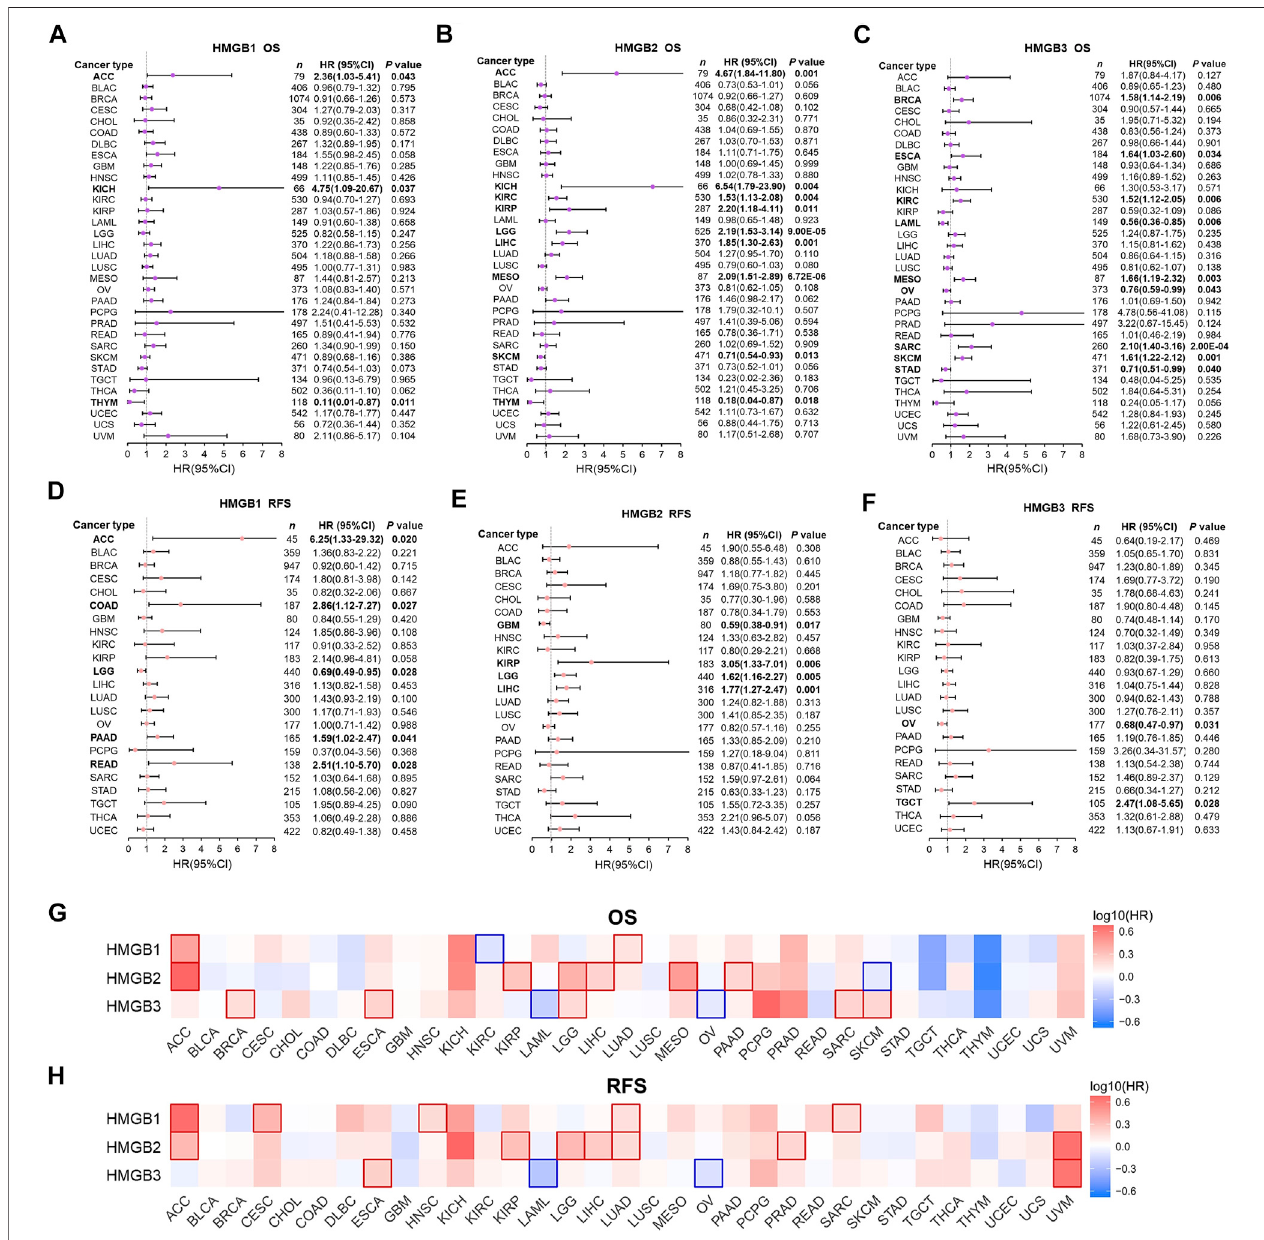
FIGURE 2 | Prognostic signi fi cance of High Mobility Group Box (HMGBs) in cancers. Associations between HMGB expression and (A – C) OS and (D – F) RFS of patients with various cancers. Heat maps showing relations of HMGB expression with (G) OS and (H) RFS of various cancers (GEPIA2). Results with signi fi cance are framed; red or blue frames indicate high or low survival risk, respectively. OS, overall survival; RFS, relapse-free survival; HR, hazard ratio; CI, con fi dence